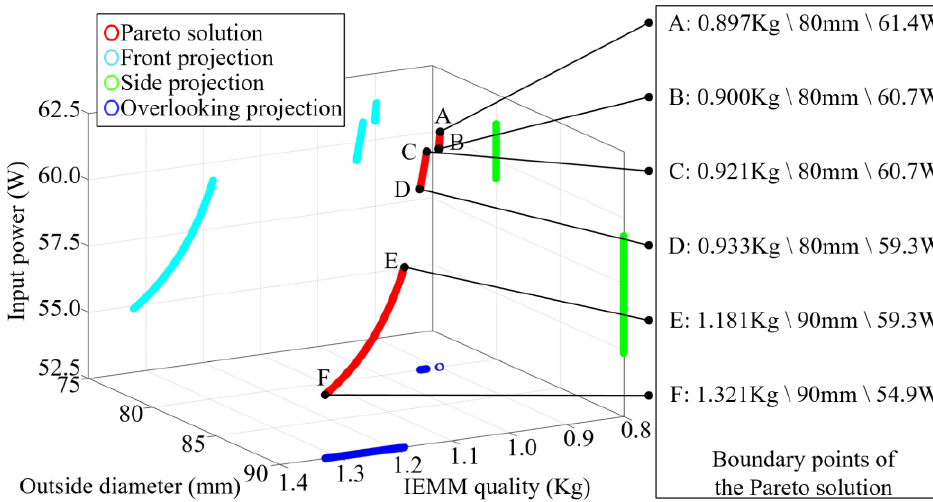
Figure 10. Pareto solution obtained by optimization.